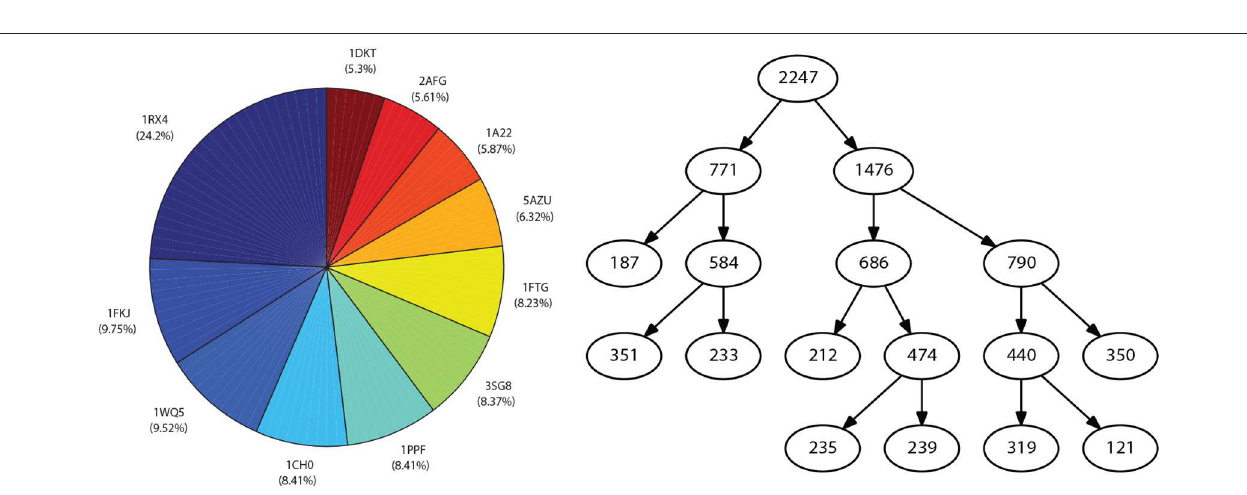
FIGURE 4 | Representation of the dataset associated with case study III: Distribution of mutations for the considered proteins (left) , and Resulting partition after applying the methodology proposed in this work (right)